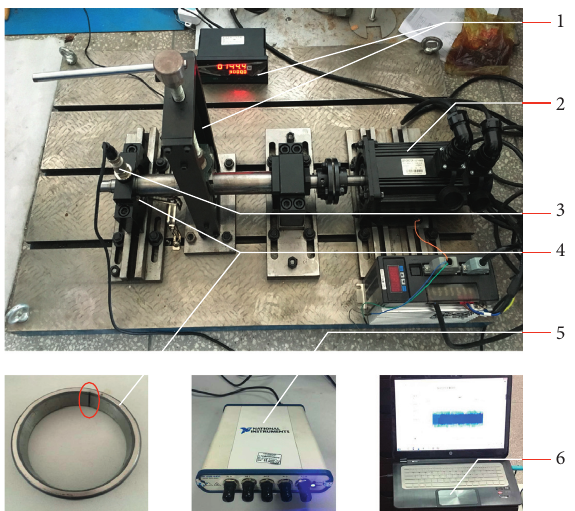
Figure 4: Rolling bearing experimental system (1, radial loading device; 2, servomotor; 3, accelerometer; 4, defect on the bearing outer race; 5, signal acquisition card; 6, computer).